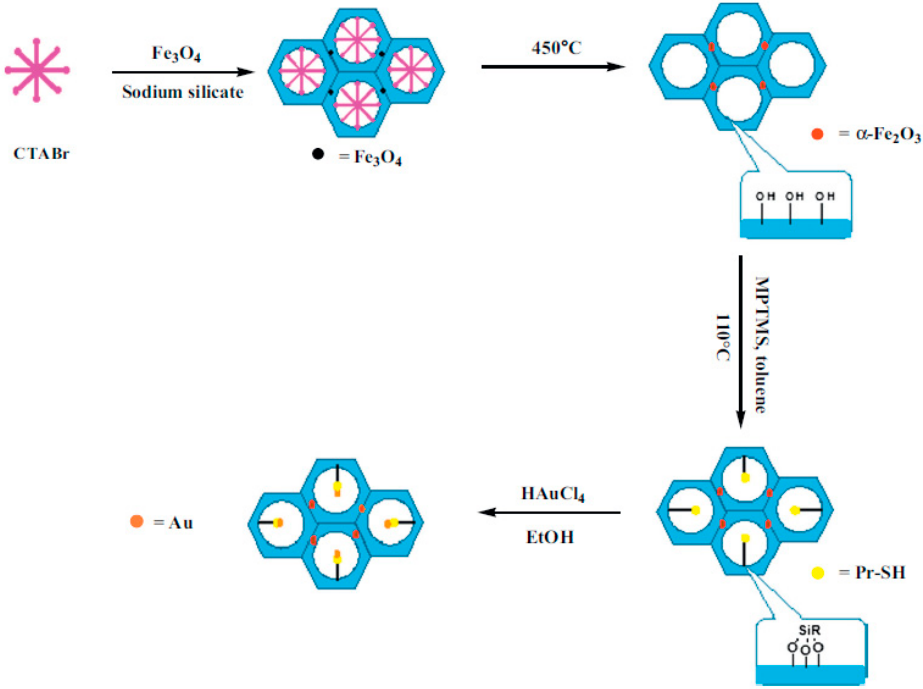
Figure 64. Preparation of ( α -Fe 2 O 3 )-MCM-41-SH-Au. Reproduced with permission from [169]. Copyright 2014 Elsevier B.V.